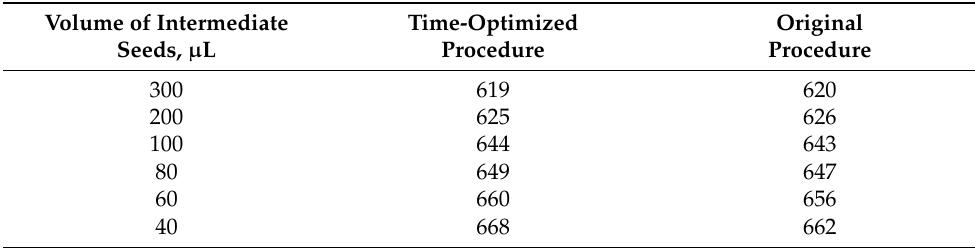
Table 2. Comparison of LSPR peak position ( λ max , nm) for the samples obtained after the time- optimized and original